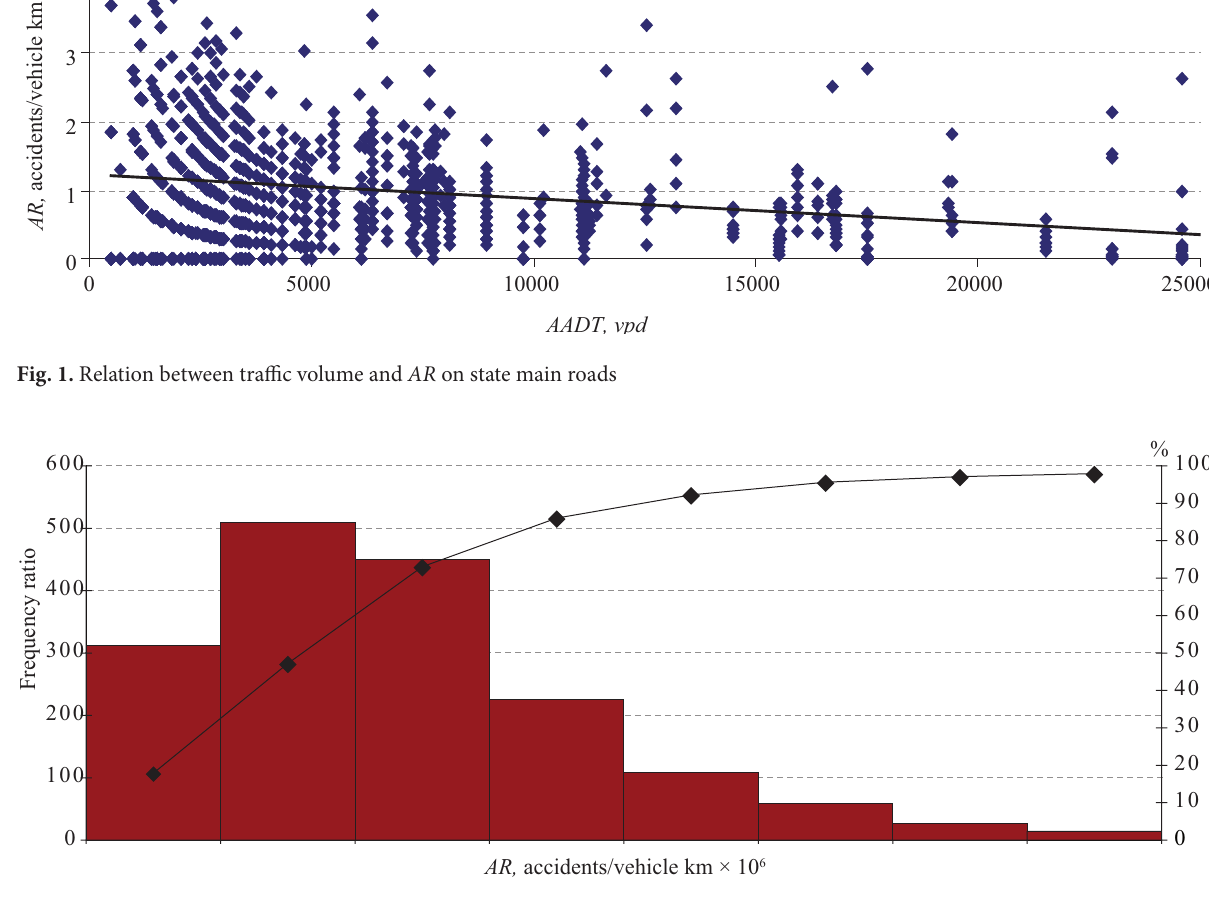
Fig. 2. Histograme and cumulative dencity function of AR